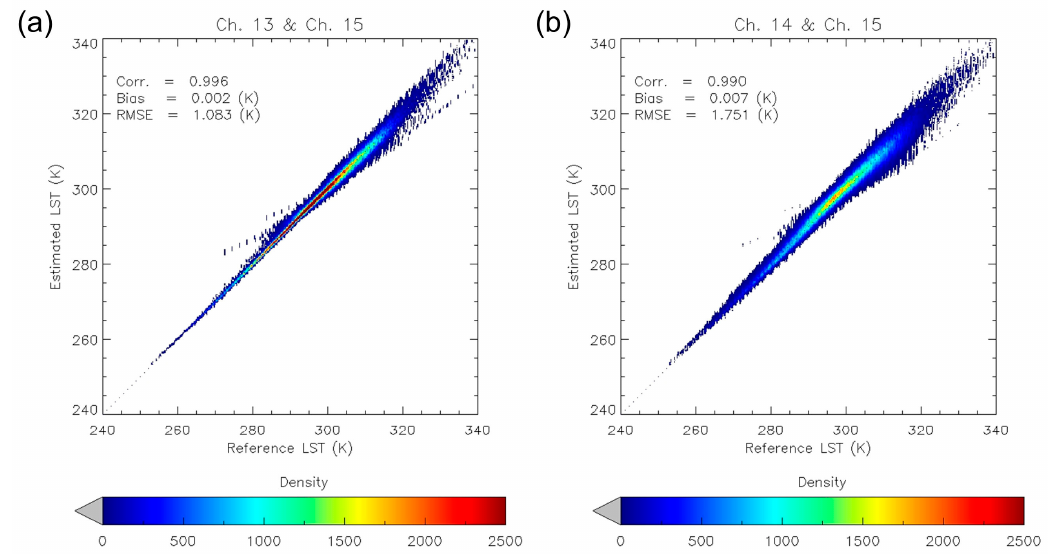
Figure 12. Scatter plot between reference LST and estimated LST from RTM simulation using Himawari-8/AHI LST retrieval algorithm: ( a ) channels 13 and 15, and ( b ) channels 14 and 15.